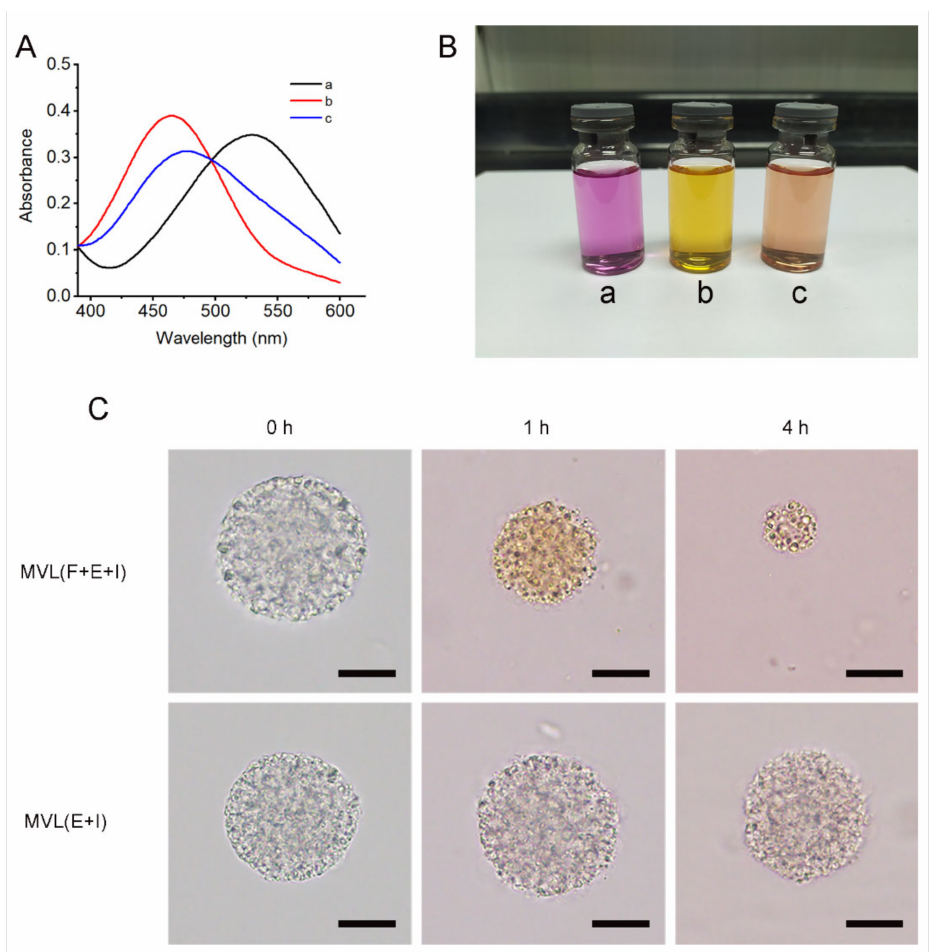
Figure 7. Glucose-responsive mechanism of MVL(F+E+I): ( A ) UV absorption spectra of 10 − 4 M Alizarin red ( a ), a mixture of 10 − 4 M Alizarin red and 10 − 3 M FOP ( b ), and a mixture of 10 − 4 M Alizarin red, 10 − 3 M FOP and 10 − 1 M glucose ( c ) in PBS (pH 7.4). ( B ) Colors of solutions a, b, and c in Figure 6A. ( C ) Photomicrographs of MVL(F+E+I) and MVL(E+I) in PBS (pH 7.4) with 1% Alizarin red at 0 h, 1 h, and 4 h, respectively. Scale bar = 20 µ